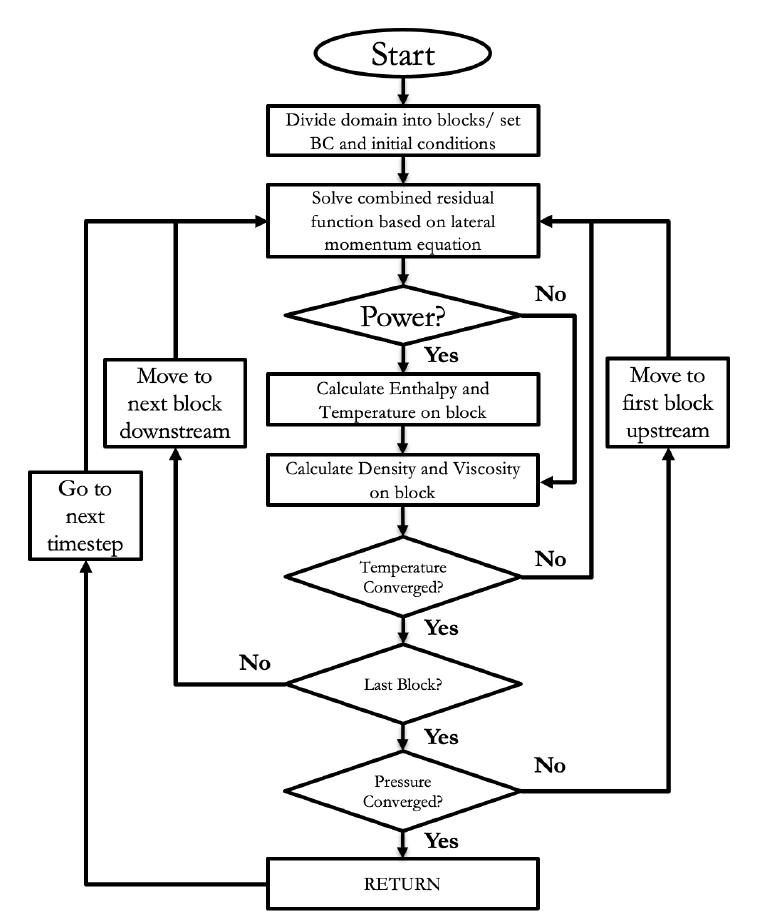
Figure 4. Subchannel hybrid numerical